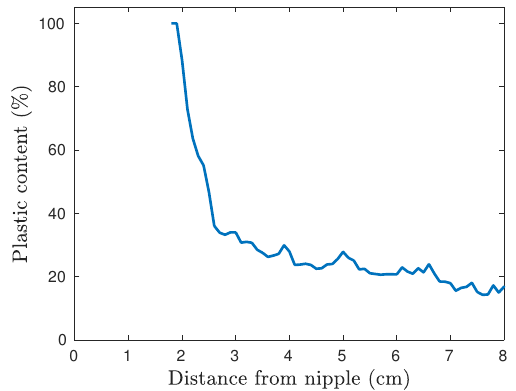
Figure 11. Plastic surface percentage of the cross sectional coronal planes of the fibroglandular shell as function of distance from the nipple.